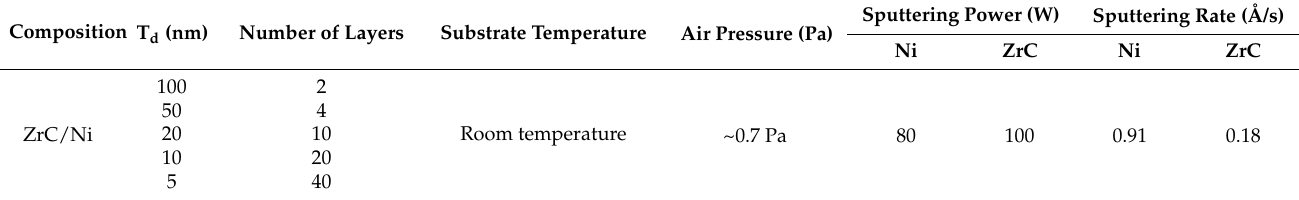
Composition T d